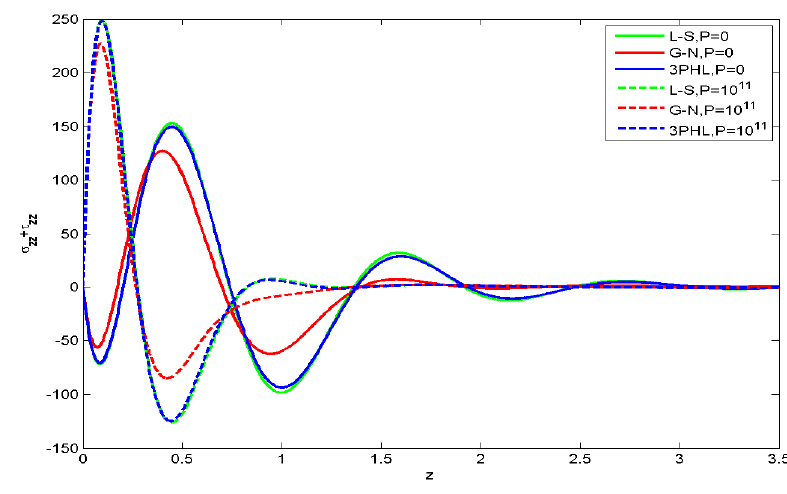
Figure 7. Maxwell’s stress zz τ concerning z under thermoelastic theories.